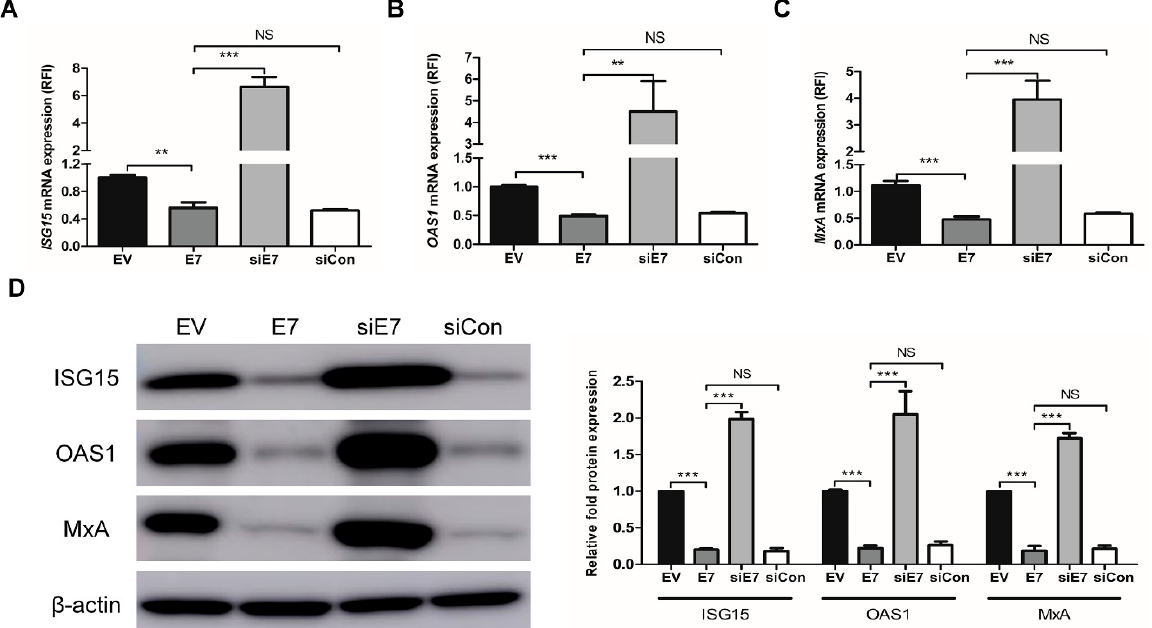
Figure 2. Effect of HPV-2 E7 transfection on the expressions of interferon-stimulated genes. HaCaT cells were transfected with empty vector, E7 , E7 specific siRNA, and negative control siRNA (siCon). After transfection, mRNA expression levels of ISG15 ( A ), OAS1 ( B ), and MxA ( C ) were analyzed by RT-qPCR. The relative mRNA levels were normalized against levels of GAPDH . ( D ) Protein expression levels of ISG15, OAS1, and MxA were evaluated by western blot. The histogram shows quantitative representation of the protein levels of ISG15, OAS1, and MxA obtained from a densitometric analysis. β -actin served as a loading control for protein normalization. The data are shown as the means ± SEM of at least three independent experiments. ** p < 0.01, *** p < 0.001 compared with empty vector or E7 . NS, non-significant.